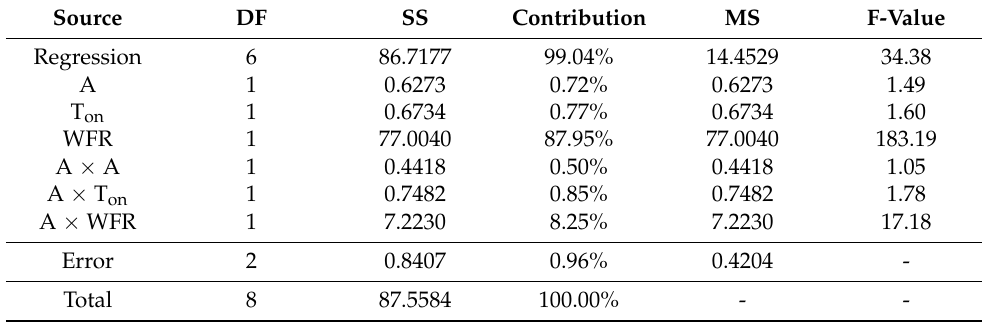
Table 10. Analysis of variance: surface roughness—Al6351–5% SiC–10% B 4 C.